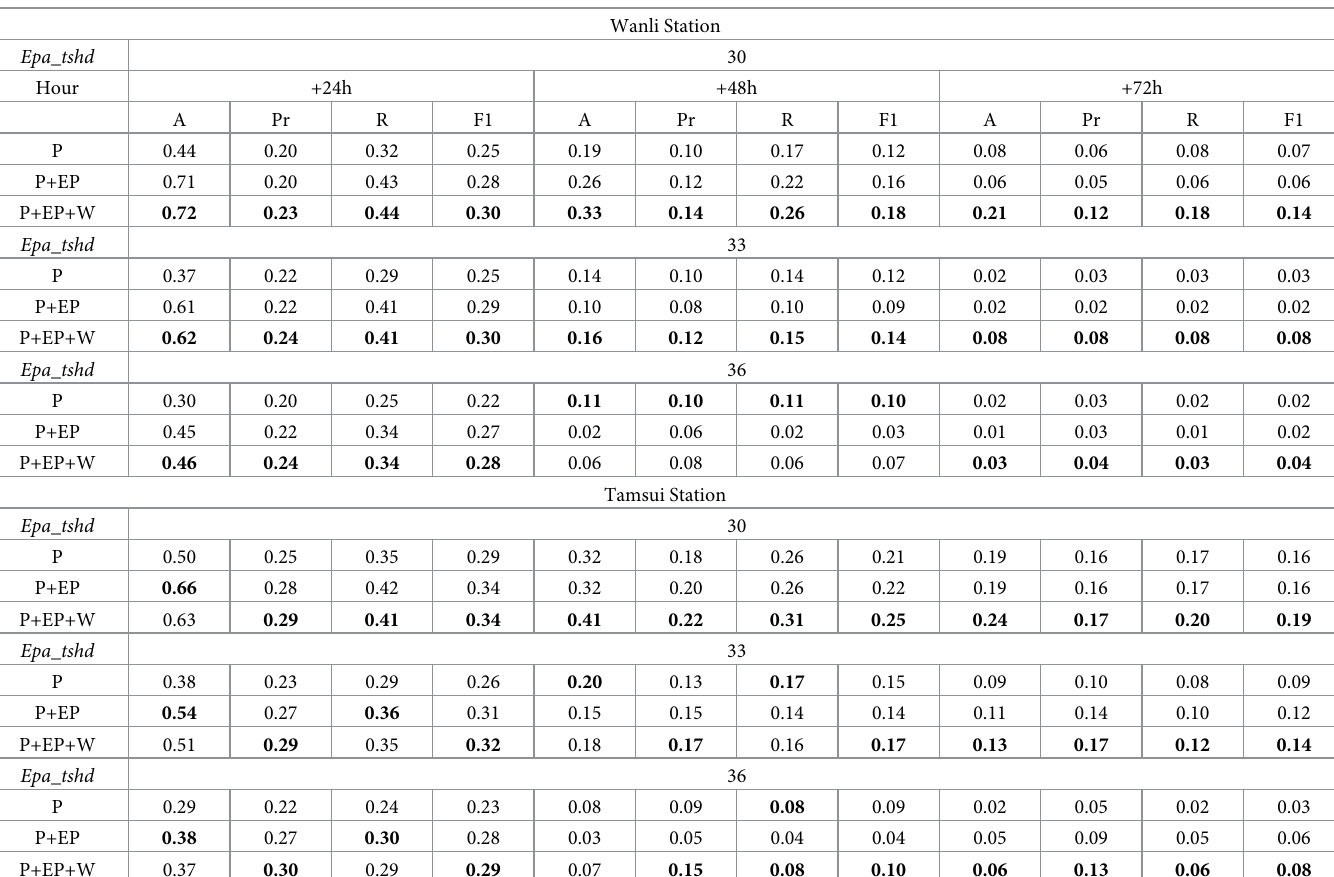
Table 3. Classification results with Diff_tshd = 0.5 .